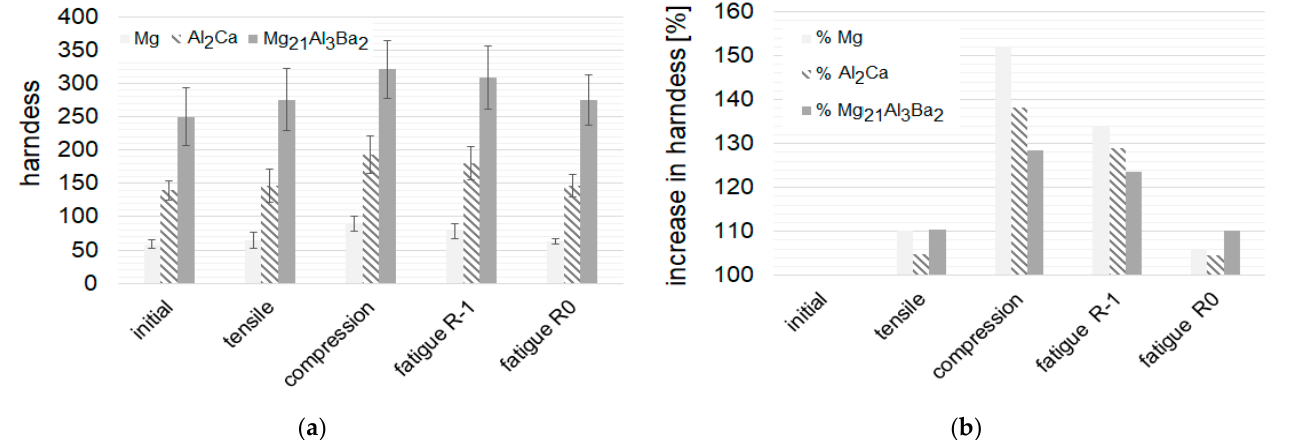
Figure 11. Bar charts of the hardness and hardness increase of the α -Mg grains, the lamellar Ca-rich phase Al 2 Ca and the blocky Ba-rich phase Mg 21 Al 3 Ba 2 before and after loading, absolute values ( a ) and increase in percentage compared to the initial hardness ( b ).